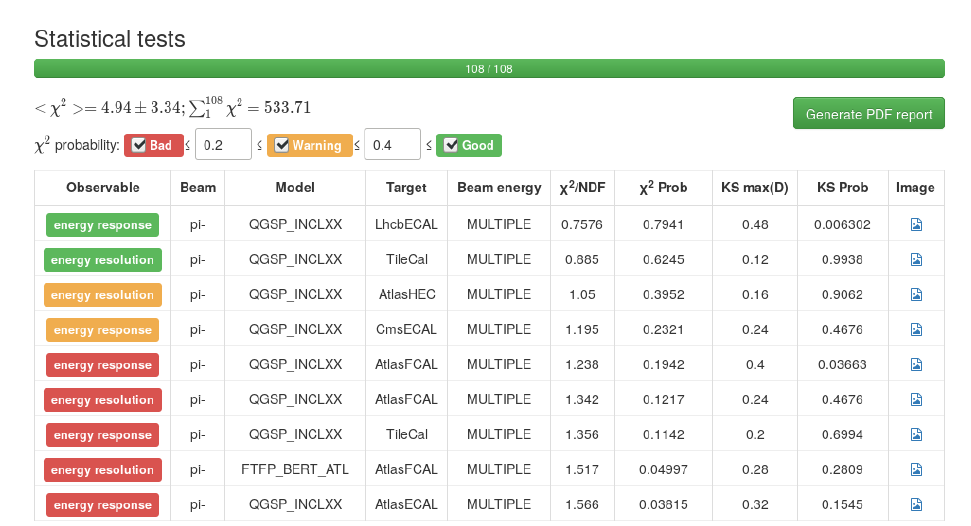
Figure 3. Statistical comparison of "simplified calorimeter" test results between Geant4 releases 10.5.beta01 and 10.4.p02 for π beam. −